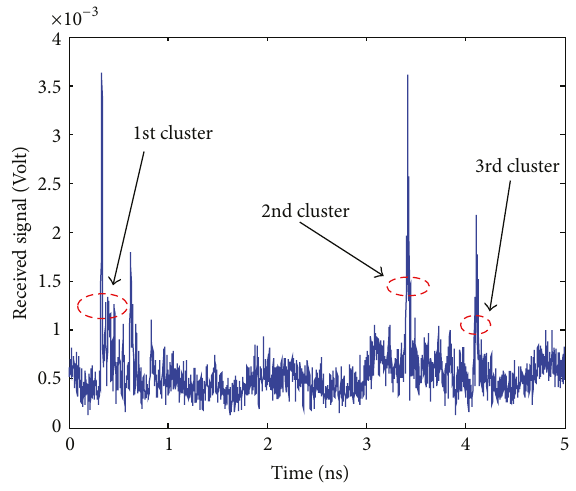
Figure 3: The measured UWB received